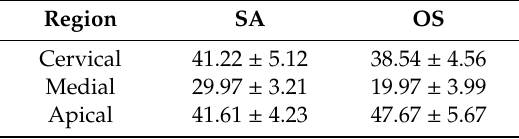
Table 3. Regional distribution of BV /